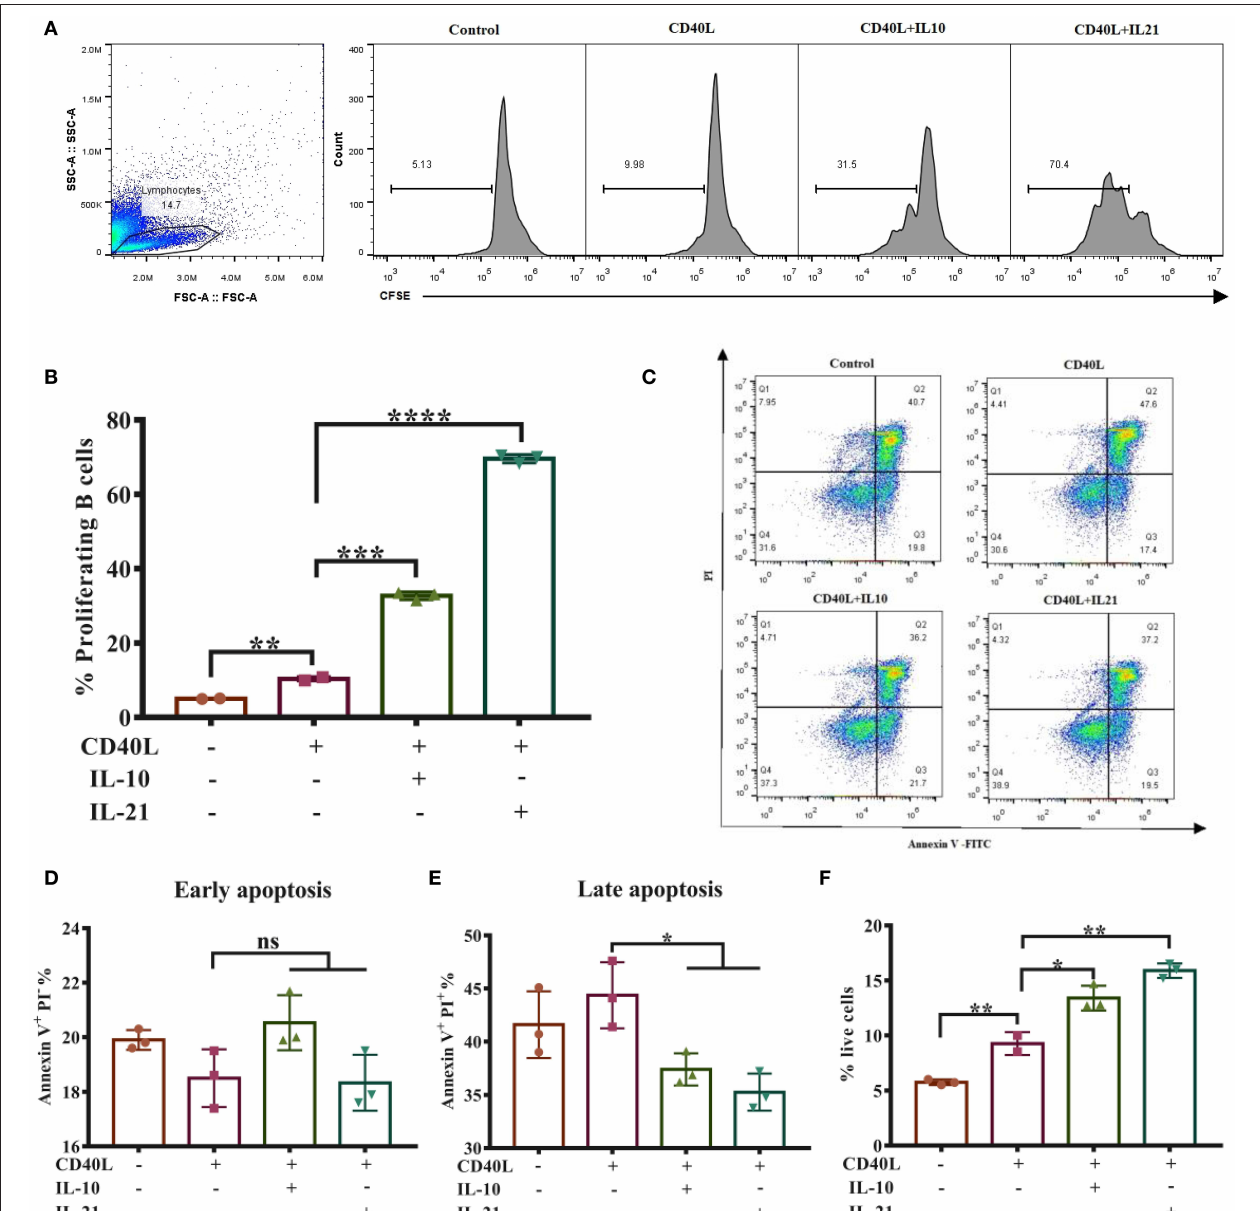
FIGURE 2 | IL-21 promotes IgM + B cell proliferation and inhibits their apoptosis. IgM + B cells labeled with CFSE were cultured alone or with CD40L/IL-10/IL-21 for 3 days, after which the cells were collected and detected through flow cytometry, and the live cell percentage and proliferation rate were analyzed. The representative of three independent experiments was shown for the proliferating cells in each group (A) , with quantification of proliferating B cells (B) . After culturing for 2 days alone or with CD40L/IL-10/IL-21, IgM + B cells were collected and labeled with Annexin V-FITC and PI and detected by flow cytometry. Representative flow cytometry plots showing apoptotic cells in each group (C) , showing quantification of early apoptotic cells (D) or late apoptotic cells (E) . The percentages of live cells were calculated in each group (F) . * p ≤ 0.05; ** p ≤ 0.01; *** p ≤ 0.001; **** p ≤ 0.0001.